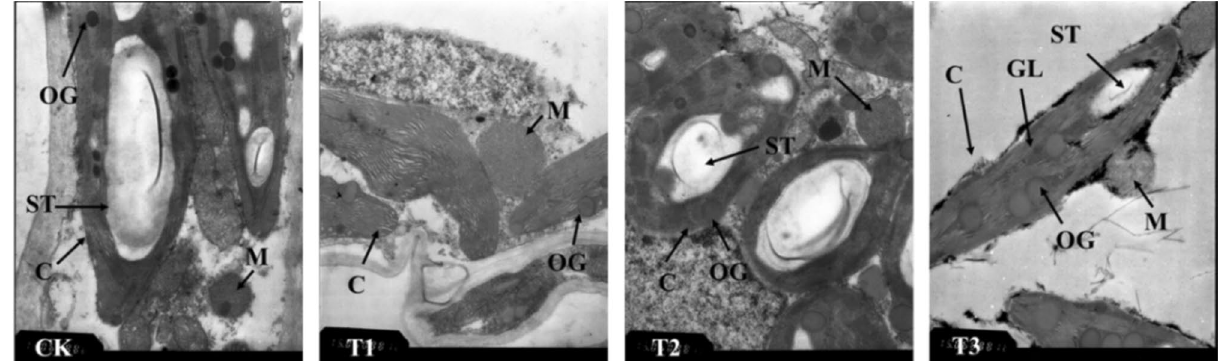
Figure 11. TEMs of Phedimus aizoon L. leaves under drought stress (× 15,000). C, chloroplast; ST, starch grain; M, mitochondrion; CB, cytomembrane; OG, osmiophilic globule; GL, granum